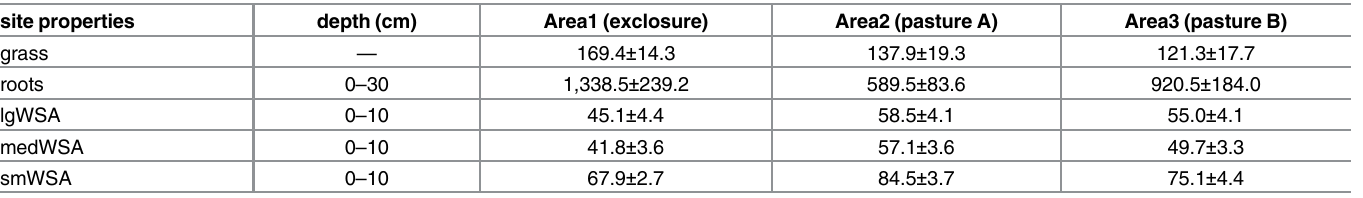
Table 1. Mean ( ± 95% CI) plant properties and soil aggregate stability values for three adjacent areas on a relatively flat upland site (0.3 ha) of north- ern mixed-grass prairie vegetation. Variation among the three areas can be interpreted by whether 95% CI overlap. site